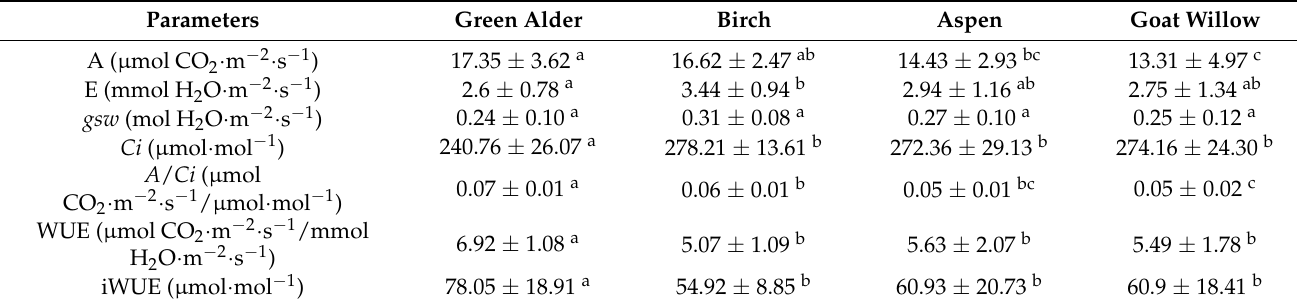
Table 1. Mean values ( ± standard deviation) of photosynthetic parameters for the 2019 growing season, at 400 µ mol · mol − 1 CO 2 concentration and 1000 µ mol · m − 2 · s − 1 PPFD. Significant differences are shown using letters following the Tukey test ( p <